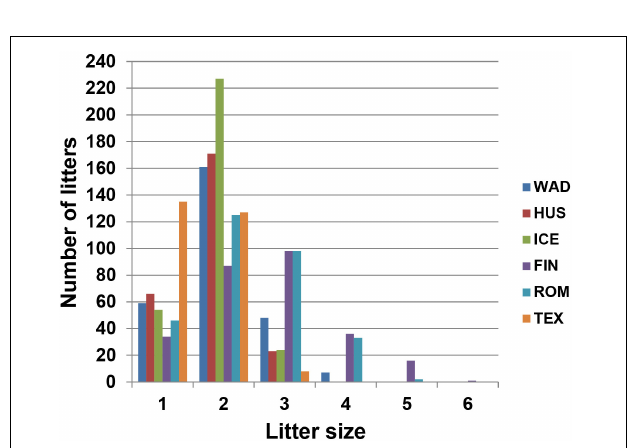
FIGURE 2 | Phenotypic distribution of litter size in the six sheep breeds (WAD, Wadi sheep; HUS, Hu sheep; ICE, Icelandic sheep; FIN, Finnsheep; ROM, Romanov sheep; and TEX, Texel